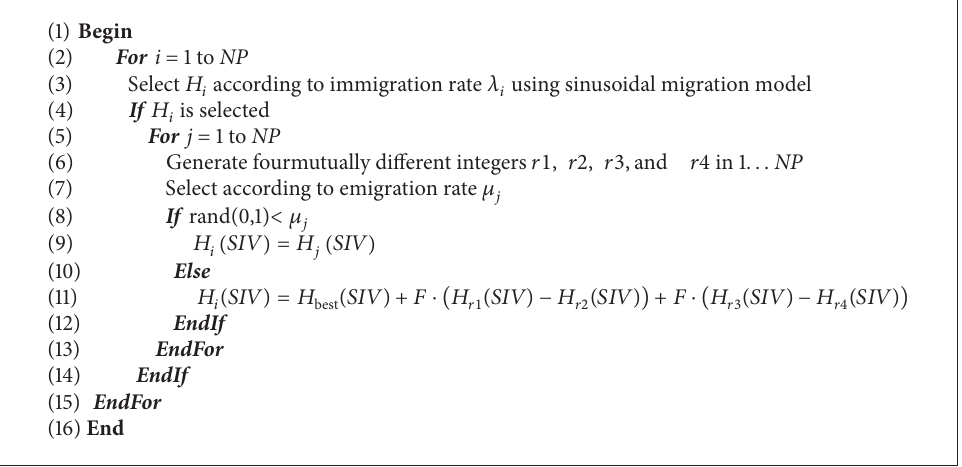
Algorithm 2: Pseudocode of modified migration